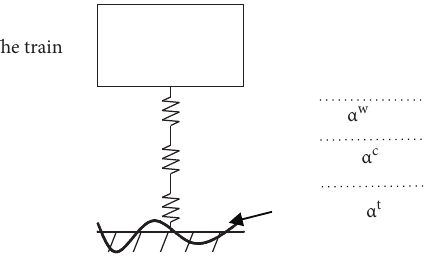
Figure 11: Wheel-rail interaction model.